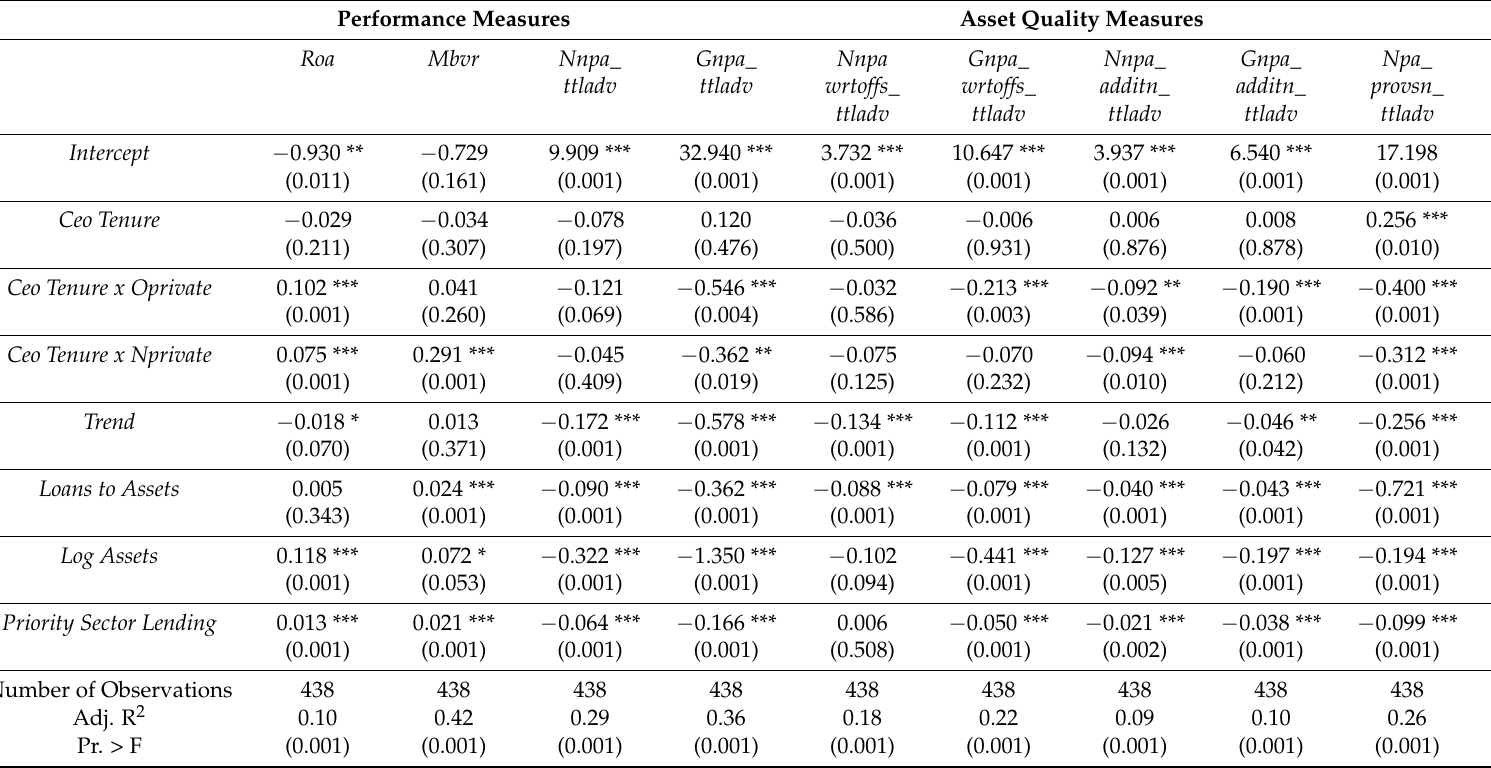
Table 10. CEO Tenure and Bank Performance: Ownership